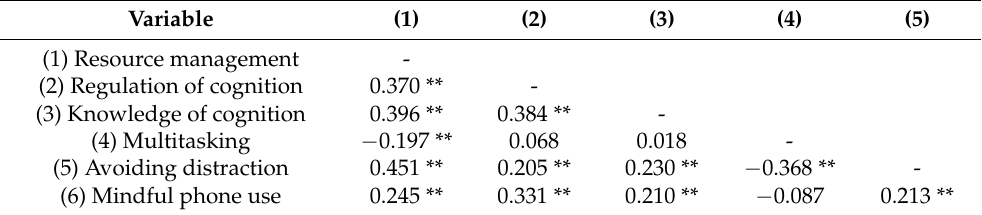
Table 6. Correlations for all